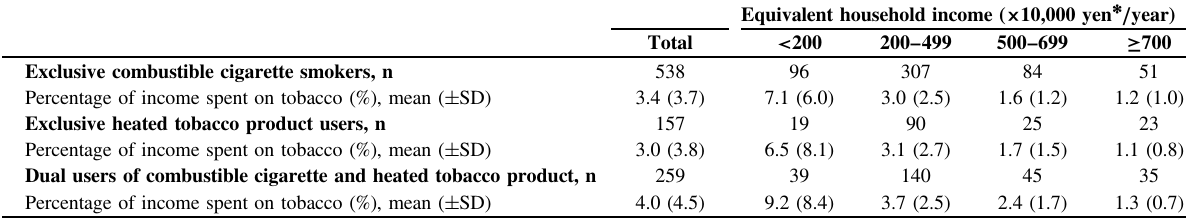
Table 2 Percentage of income spent on tobacco according to equivalent household income